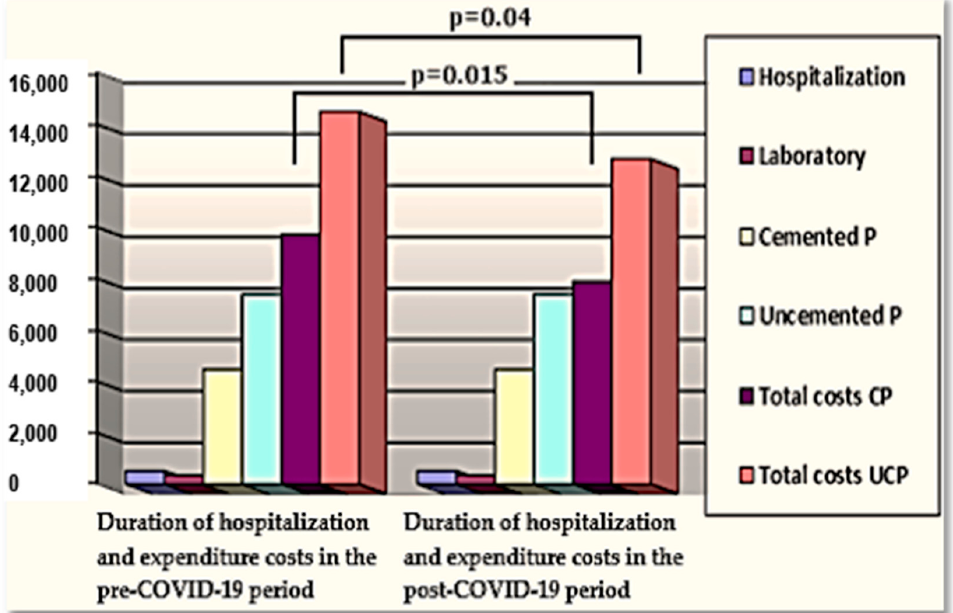
Figure 3. Data concerning the management of THA with CHP and CLHP preceding and following the COVID ‐ 19 pandemic. Legend: prosthesis—P; cemented prosthesis—CP; uncemented prosthe ‐ sis—UCP.